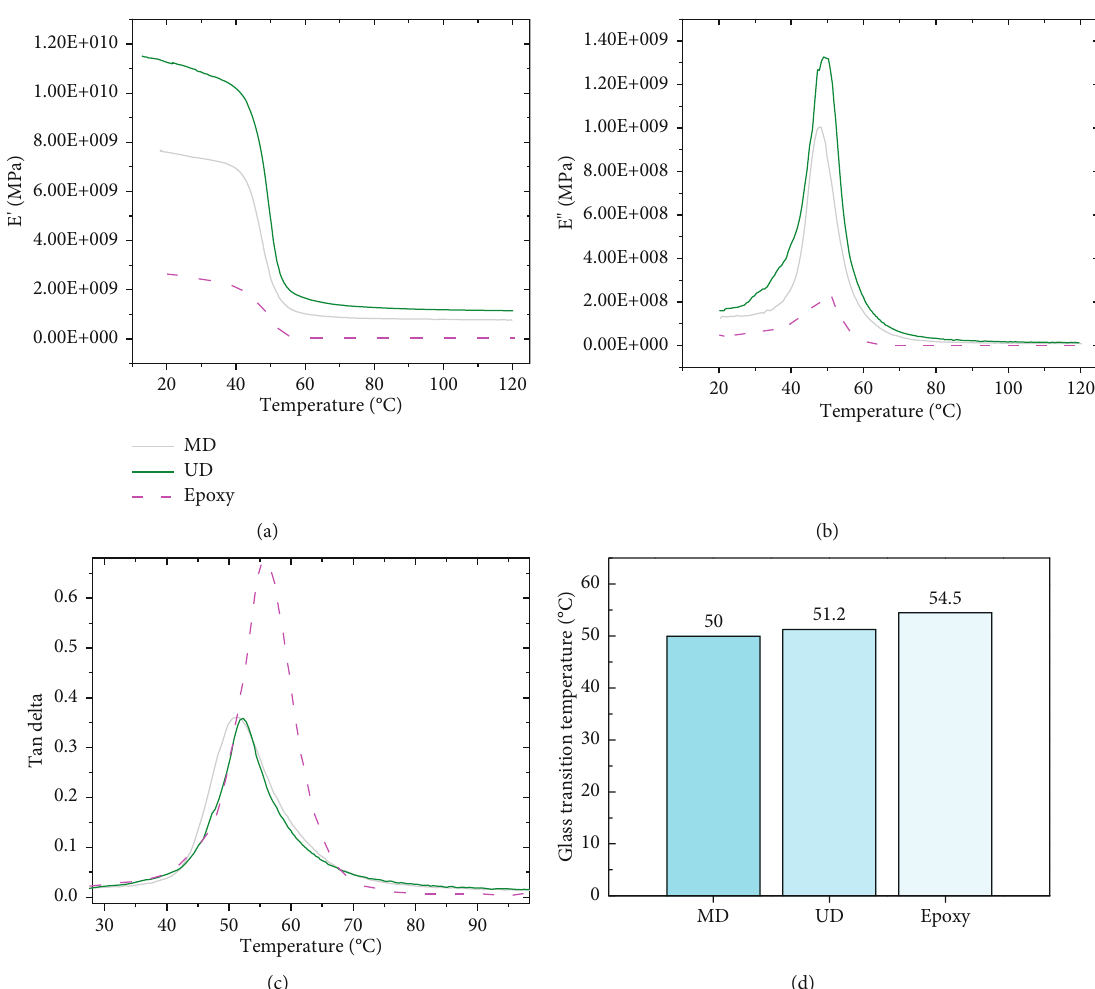
Figure 1: Line graphs of (a) the loss modulus, (b) the storage modulus, (c) the tan delta, and (d) the glass transition temperature for the UD and MD